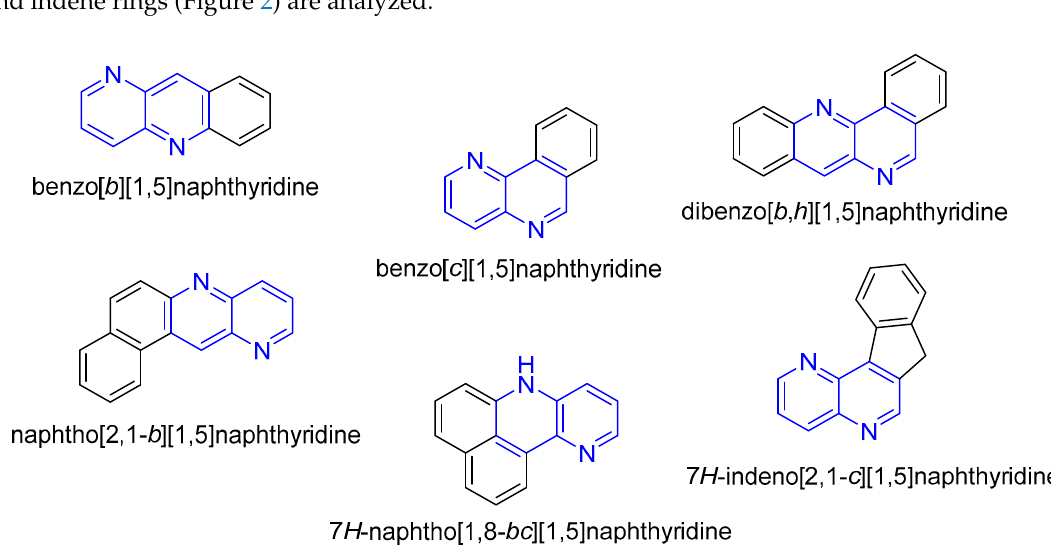
Figure 1. Fused naphthyridines with biological applications.